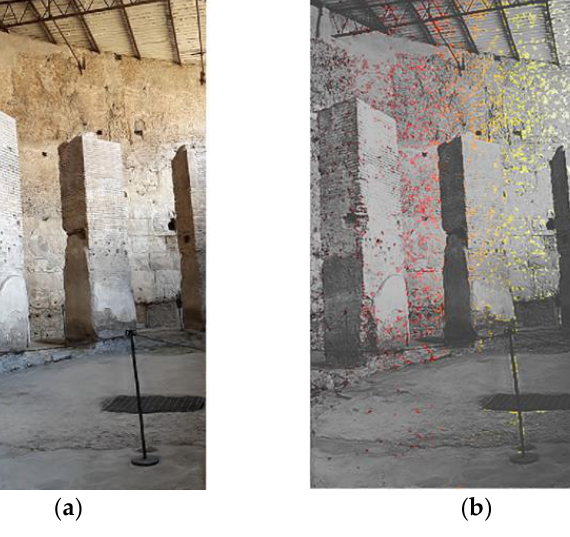
Figure 14. Columns of the Exedra: ( a ) original frame of recorded video; ( b ) relative normalized displacement pattern; ( c ) image entropy analysis.